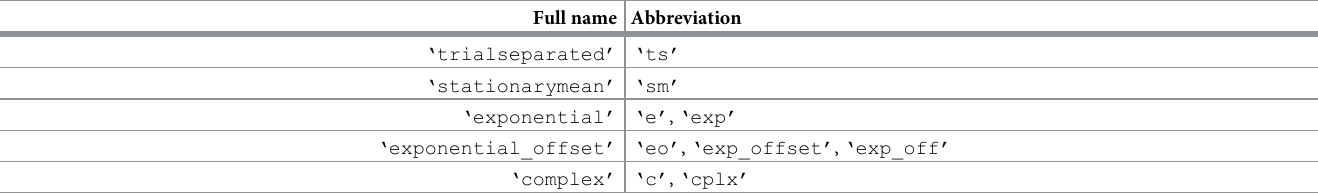
Table 2. The (lengthy) descriptions of fit-functions and coefficient-methods can be